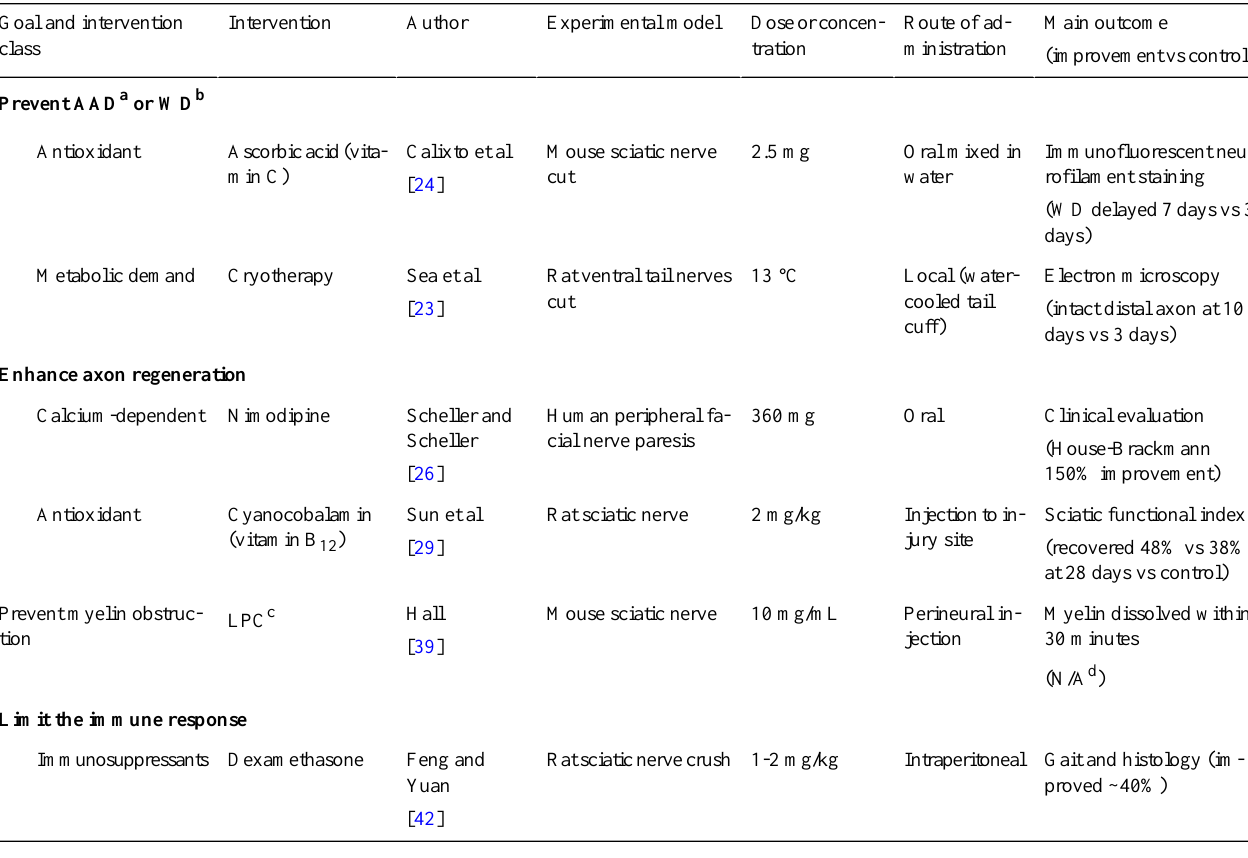
Table 1. Interventions and evidence.